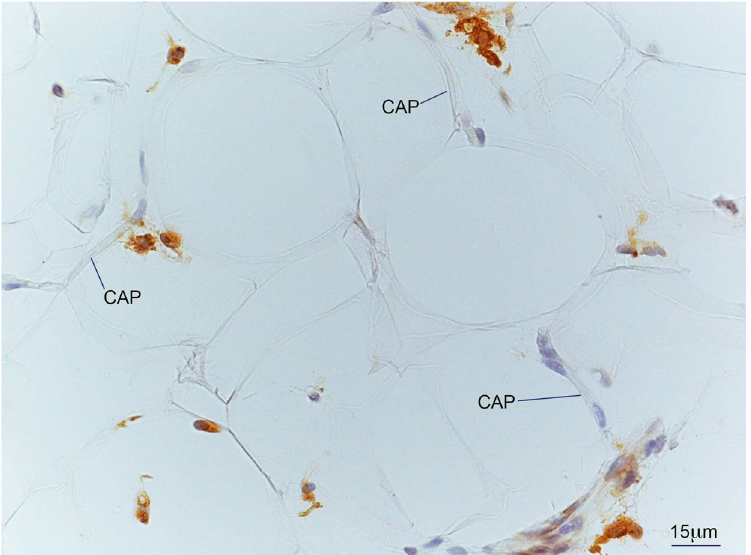
Figure 5. Light microscopy of subcutaneous adipose tissue (SAT) of an obese patient with type 2 diabetes post- surgery. Immunohistochemistry for CD68. Several CD68 immunoreactive macrophages (brown) are present among unstained adipocytes and capillaries